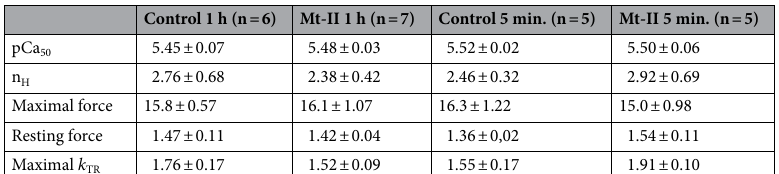
Figure 3. Skinned cardiomyocytes were not affected by Mt-II. ( a ) Force-pCa relation of skinned cardiomyocytes exposed to 50 µg/mL Mt-II for one hour in relaxing solution. Calcium-induced force development was not different from those of control cells undergoing the same procedure without Mt-II exposure. ( b , c ) A short time (5 min.) Mt-II exposure (same concentration as above) of control cells in ( a ) did not affect force pCa-relation (see b ), which excludes the possibility of a short-term effect of Mt-II on a repeated measurements basis. A masked, accumulative effect in ( b ) (for example decreased force generation induced by mechanical cell deterioration with simultaneous increased force generation induced by the toxin) is excluded by data presented in ( c ), showing no mechanical cell deterioration in the second activation without toxin. ( d ) A short-term Mt-II effect is also excluded on an individual group basis, when short-term incubations of cardiomyocytes in ( b ) and ( c ) are compared. Data in ( d ) also confirm the high quality of skinned cardiomyocytes, since both groups of cells conserved similar patterns of force development in the second activation. ( e ) Maximal force (KN/m 2 ) development at saturating calcium concentration (pCa 3.88) of control and Mt-II exposed cells shown in ( a – d ), including short-term (5 min) and long-term (60 min.) incubation experiments. There were no significant differences. ( f ) Same as in e for resting force at relaxing calcium concentration (pCa 7.50). ( g ) Rate constant of force development ( k TR ) at saturating calcium concentration (pCa 3.88). In spite of slightly higher standard deviations as for maximal and resting force, there were not significant differences between groups. For statistics, see Table 1. Note that figures ( a ) and ( b ) show two conditions each (control and Mt-II). Image created using GraphPad Prism (version 5.01) www. graph pad. com.